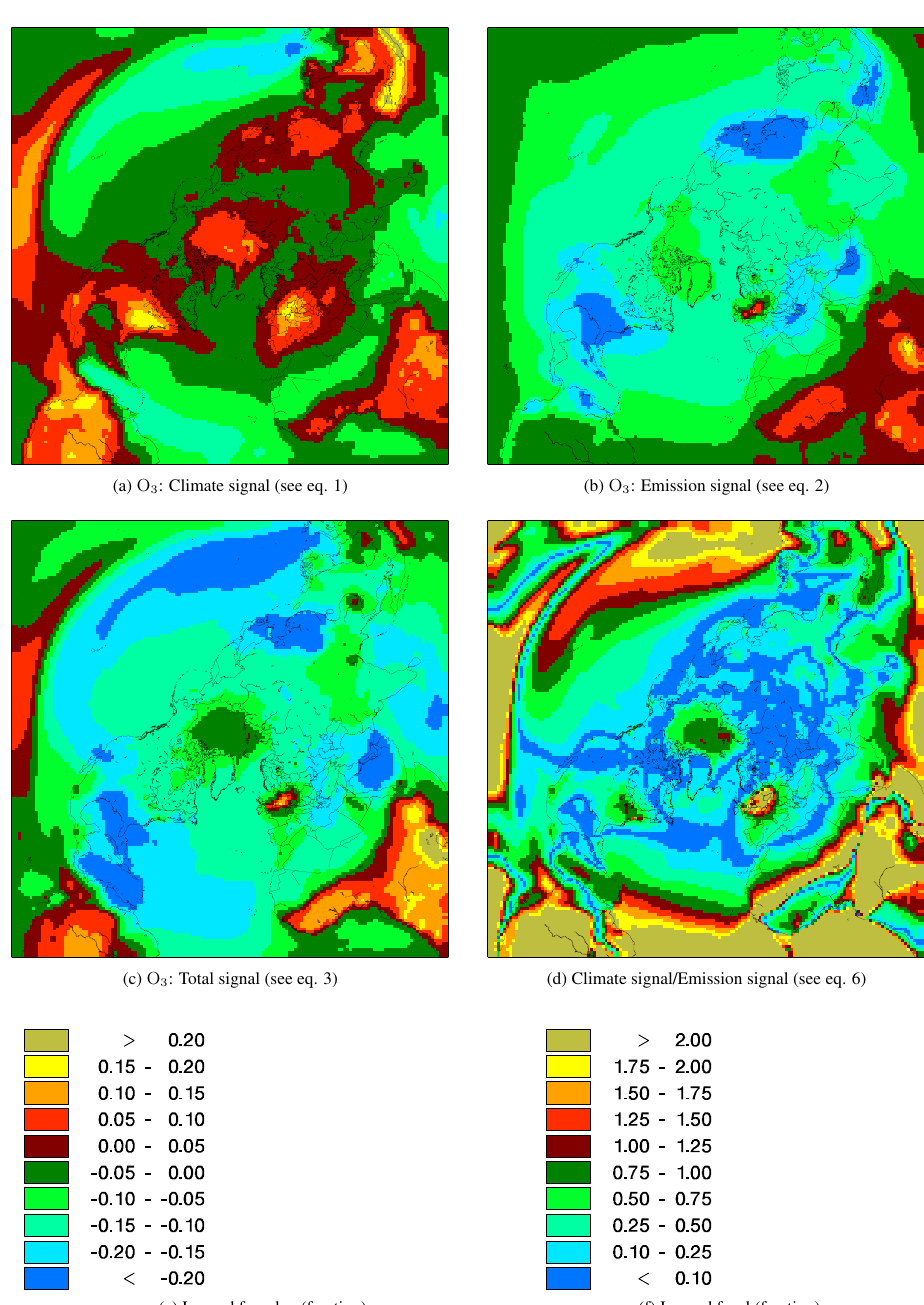
Fig. 4. O 3 : The signal from (a) future climate change, (b) future emission change, (c) the total change on the surface ozone concentration due to changes in both future climate and emissions, and (d) the climate signal relative to the emission signal. The climate signal is simulated with constant year 2000 emissions and ECHAM5 meteorology. The signal from changes in the anthropogenic emissions is simulated with projected RCP4.5 emissions and 1990s meteorology.